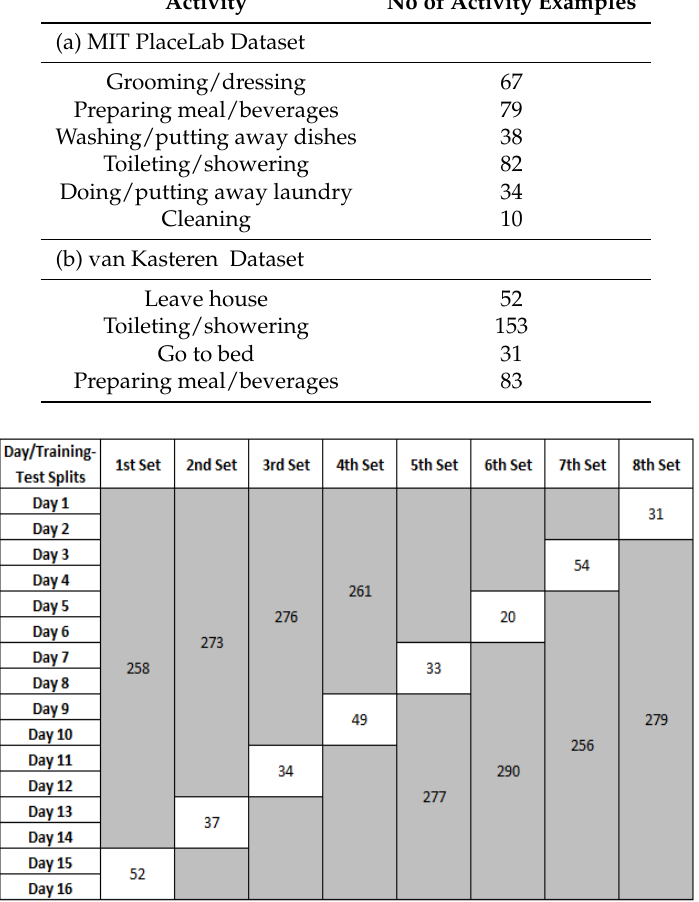
Figure 5. Leave-two days-out cross-validation on MIT PlaceLab dataset. Training sets are shaded in grey and the unshaded are testing sets. The values in each of the training-test splits refer to the number of activity examples in the training and test sets,